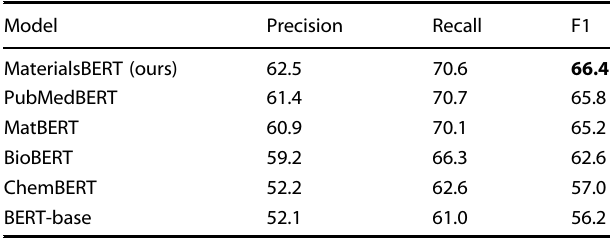
Table 2. Performance of various BERT-based encoders on the test set of PolymerAbstracts. Model